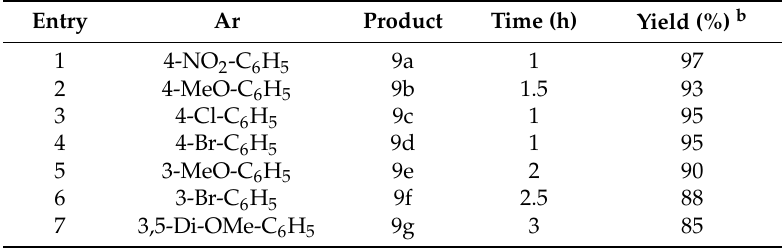
Table 3. Synthesis of benzyl pyrazolyl coumarin derivatives 9a–9g a using HUC catalyst.